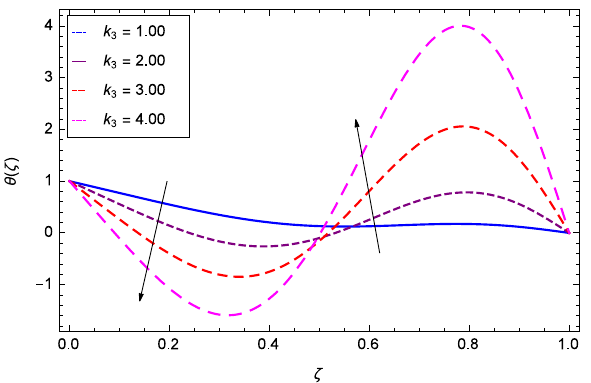
Figure 18. Analysis through stretching parameter k 3 at upper disk and temperature θ ( ζ ).